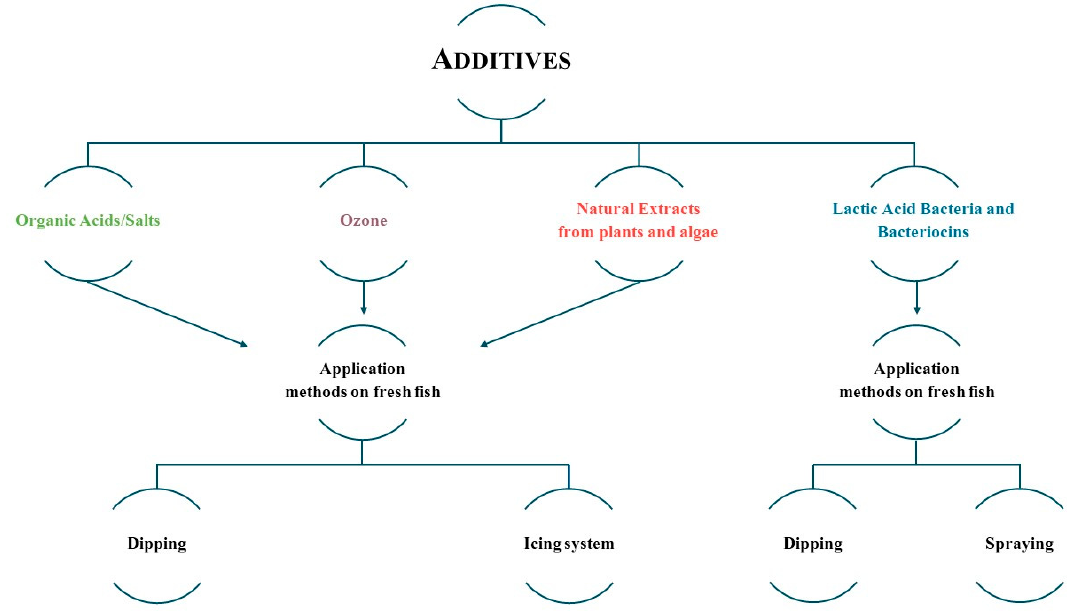
Figure 5. Chemical additives used to preserve fishery products and their application methods.